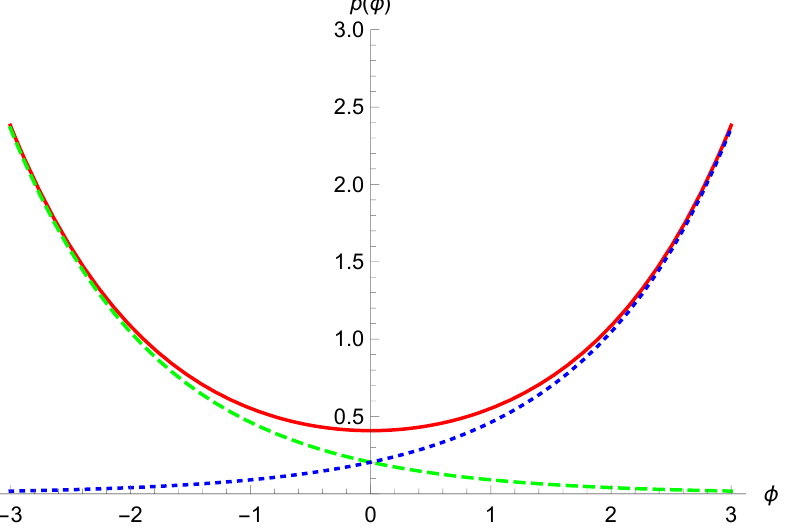
Figure 3. The polymer trajectory (red continuous line) is compared to the classical ones for the flat FLRW model. The Big Bang solution is the blue dotted line and the Big Crunch solution is the green dashed line.